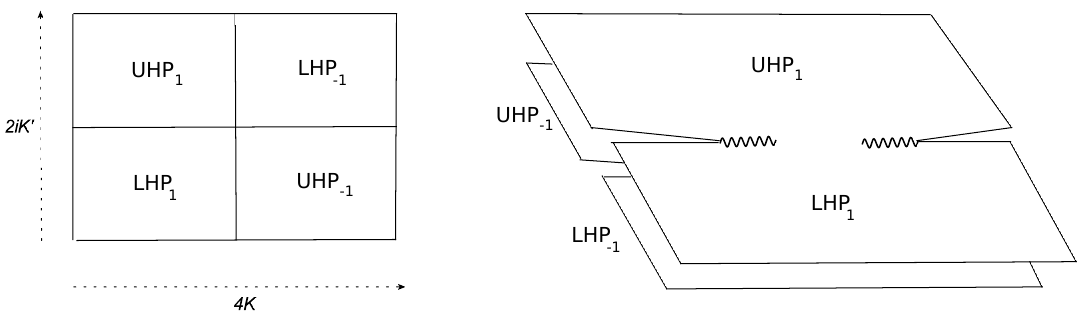
Figure 21 . The geometry in the complex y plane is of a two-sheeted Riemann surface. The elliptic substitution makes clear that this surface is a